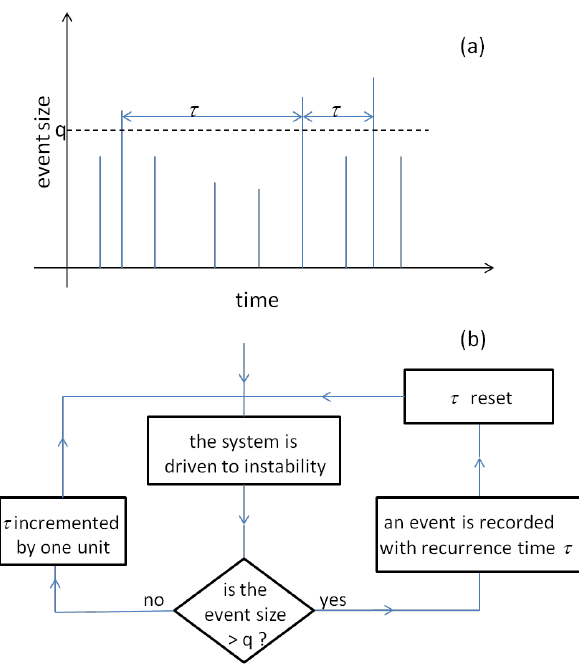
Fig. 1. (a) Graph showing the definition of the recurrence time τ ; (b) simplified flow chart of our CA model describing the algorithm Figure 1. (a) Graph showing the definition of the recurrence time  ; (b) simplified flow chart of our 3 for calculation of the recurrence time distribution p(τ) CA model describing the algorithm for calculation of the recurrence time distribution p (  ). 4 5